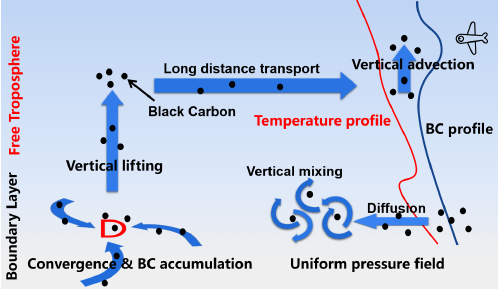
Figure 10. Formation mechanism of BC peak in the free tropo-